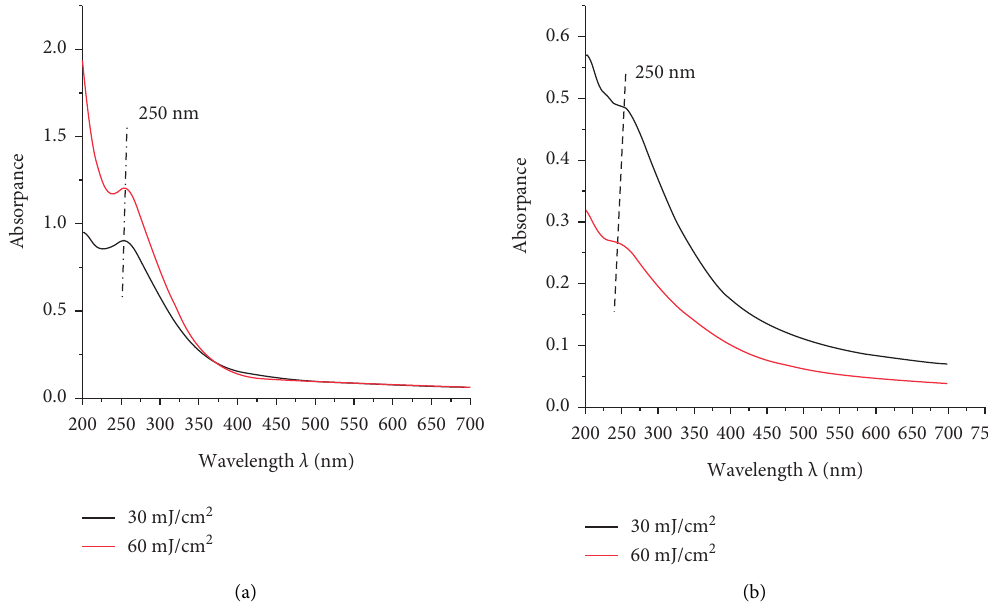
Figure 6: The optical absorbance of the NPs, prepared by LASER ablation in liquid medium with a LASER fluence of 30 mJ/cm 2 and 60 mJ/ cm 2 : (a) without the presence of the magnetic field and (b) with the presence of the magnetic